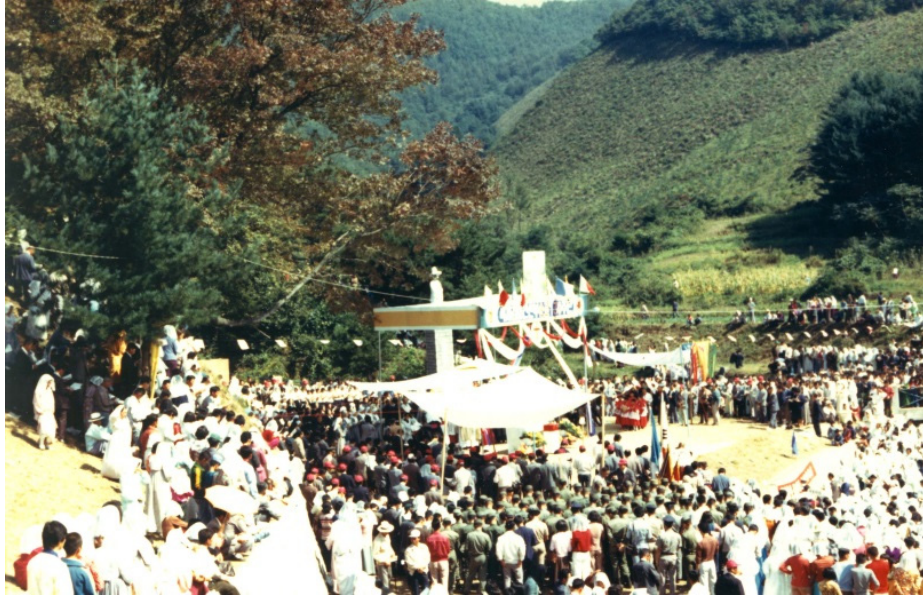
Figure 18. The 130th Anniversary of the Blessed Exaltation Convention on 26 September 1976 [source: courtesy of Mirinae Church] .